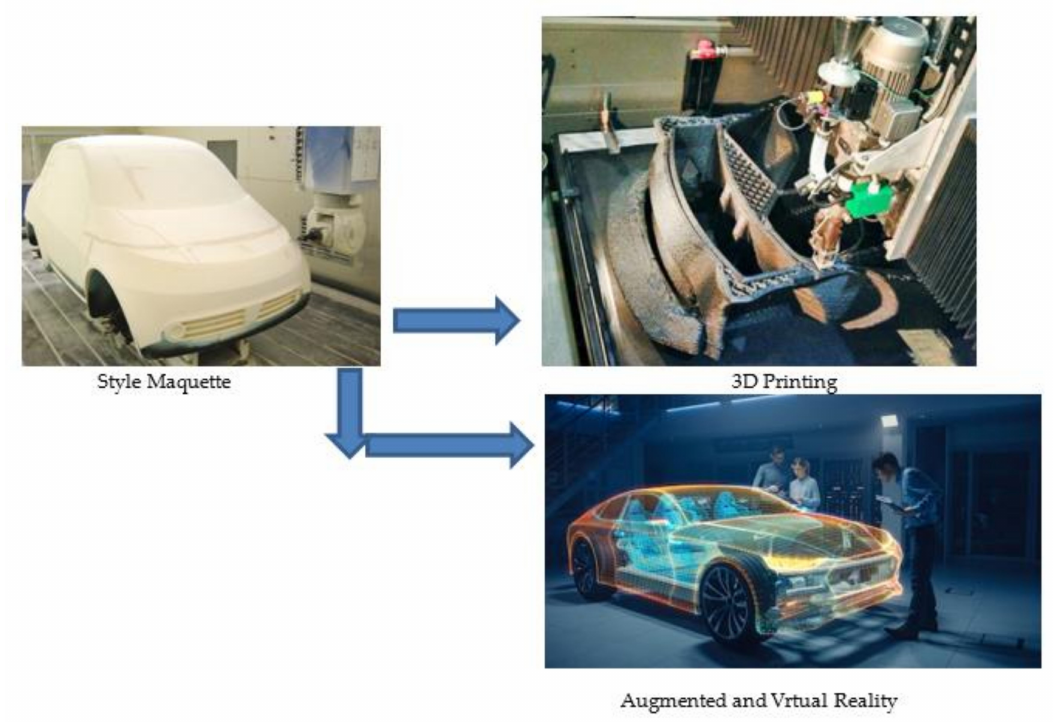
Figure 38. From “classic” Solid Stylistic Model (Style Maquette) to 3D Printing or Augmented and Virtual